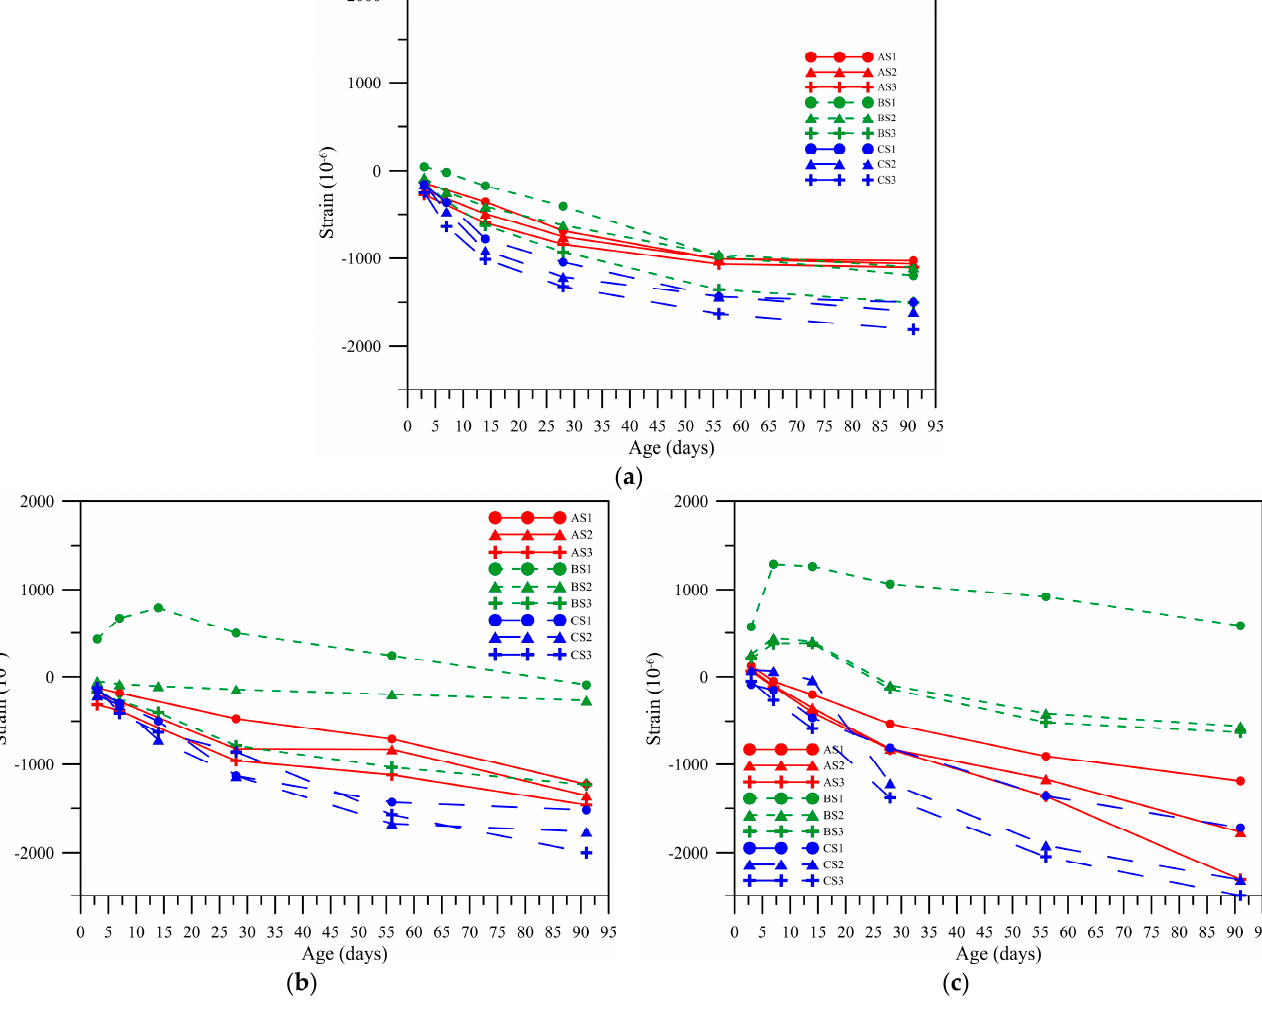
Figure 6. Drying and shrinkage of various proportions with age at different alkali equivalents. ( a ) AE% = 3%, ( b ) AE% = 5%, ( c ) AE% = 8%. ( a ) AE% = 3%, ( b ) AE% = 5%, ( c ) AE% =